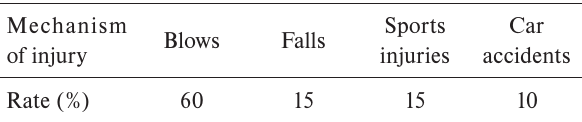
Table 1. Mechanism of injury.